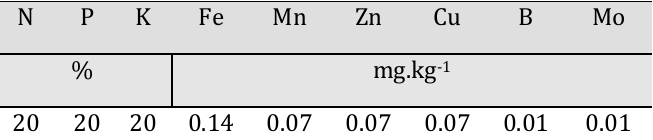
Table 1. Foliar N.P.K (20:20:20) +TE fertilizer